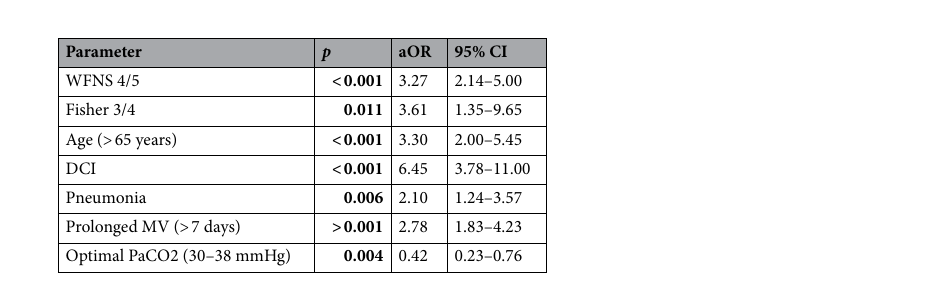
Table 5. Multivariate analysis of factors impacting the occurrence of poor outcome. Statistically significant p -values are marked bold.